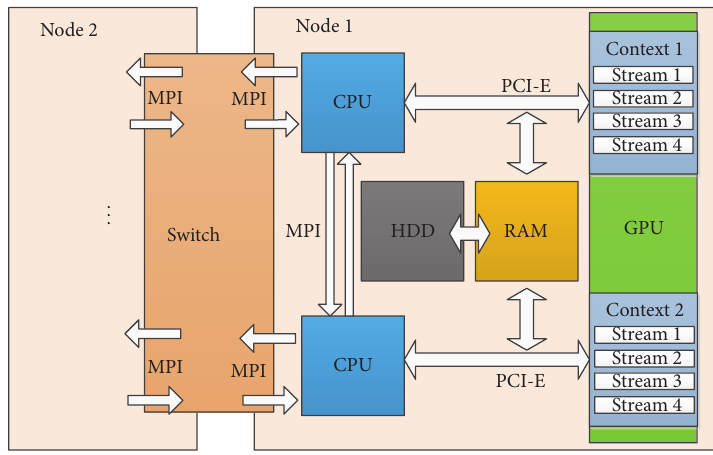
Figure 9: Software and hardware architecture of parallel out-of-core left-looking scheme.